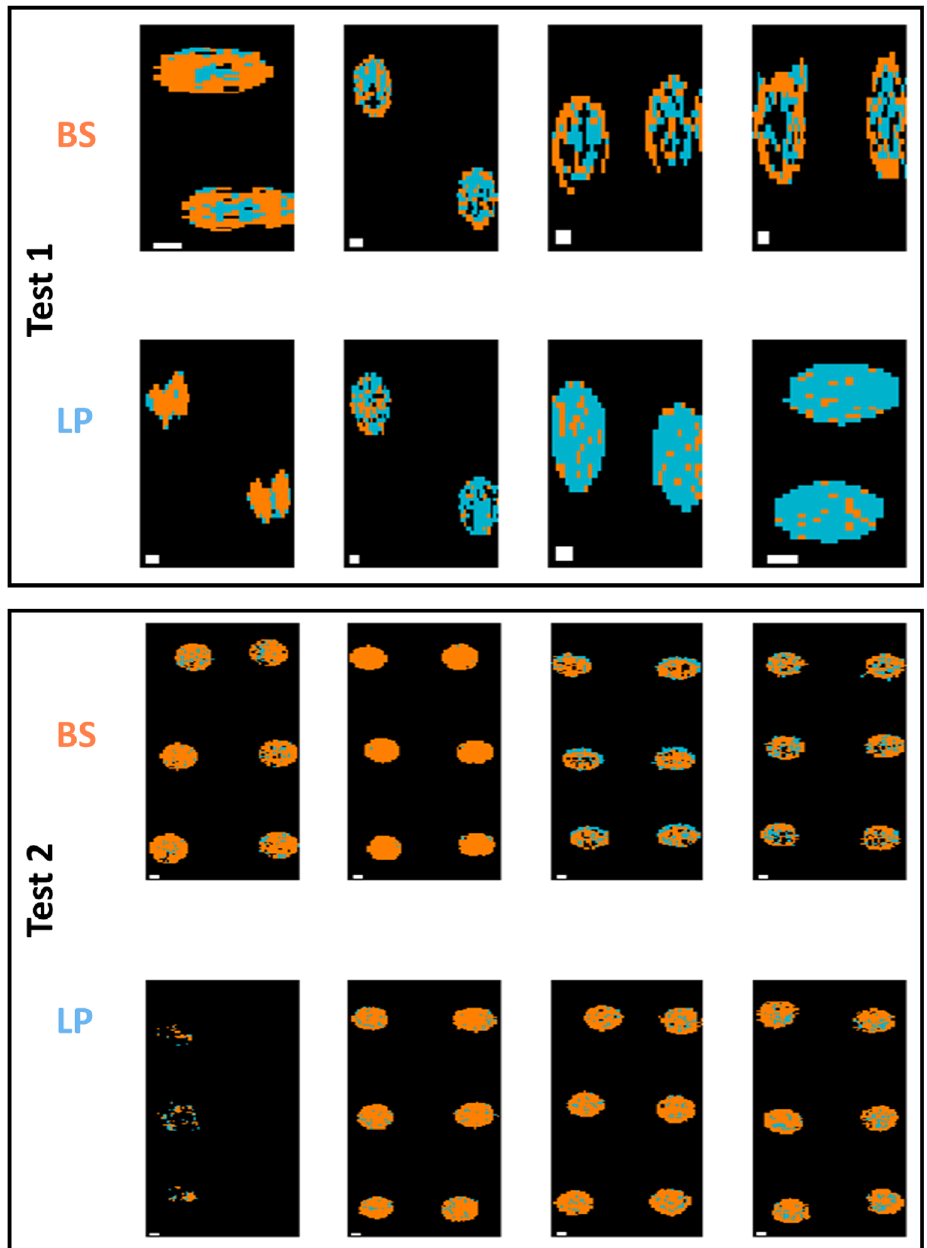
Figure 7. Classification maps for samples in the test set (reps 6, 9, 12, and 16) obtained from the best pixel level VNIR/SWIR models for GP BS/LP classification (pixels classified as BS/LP are shown in orange or blue respectively). Each replicate has two drops. BS: Bacillus subtilis ; LP: Lactobacillus plantarum . White scalebar indicates 1 mm (width) × 0.25 mm